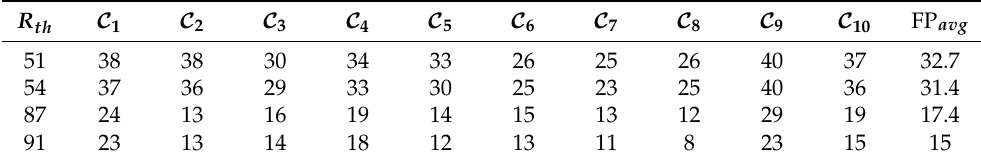
Table 8. Table of FP per CNN for each selected value of R th ; FPR is deduced from FP by the formula FPR = FP /